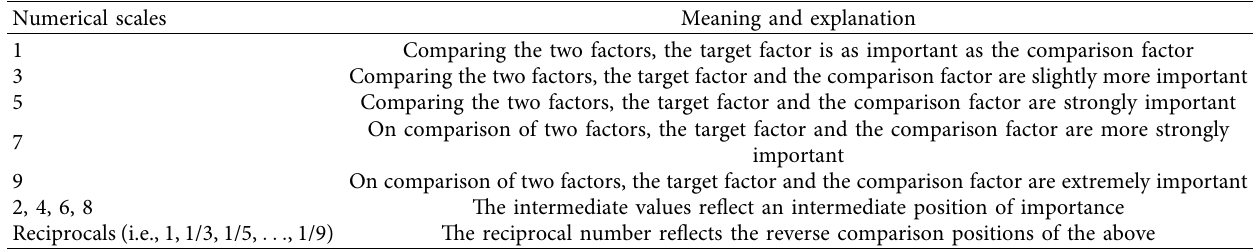
Table 1: Numerical scales of factor